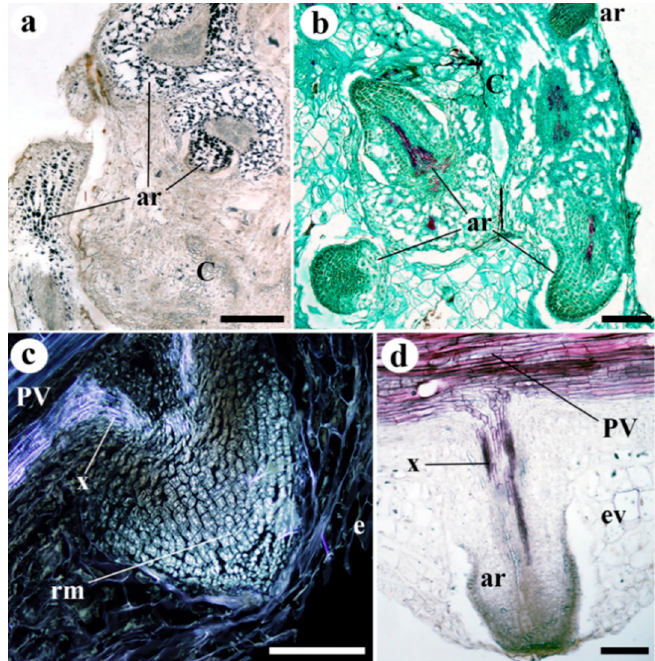
Figure 5. Adventitious roots arising from the scion at 20 days after grafting. ( a ) Longitudinal section of an adventitious root (ar); note the many amyloplasts (black dots). ( b ) Adventitious roots (ar) arising from the callus (C) of the scion near the graft junction; note how the top adventitious root breaks through the epidermis. ( c ) Longitudinal section of an adventitious root primordium, showing how it arises from the pre ‐ existing vasculature (PV); the root meristem (rm) is also distinguishable. Note how the epidermis is perforated ( e ). ( d ) Longitudinal section of an adventitious root (ar) primordium, showing how the root vascular tissue arises from the pre ‐ existing vasculature (PV). Note the enveloping parenchyma around the structure of the root (ev). ( a ) Lugol; ( b ) Safranin ‐ fast green; ( d ) Phloroglucinol. ( a , b , d ) Bright field view. ( c ) Epifluorescence microscopy. ar adventitious root, C callus, e , epidermis, ev enveloping parenchyma, PV pre ‐ existing vascular tissue, rm root meristem, x xylem. Scale bars: a = 300 μ m; b = 200 μ m; c, d = 100 μ m.